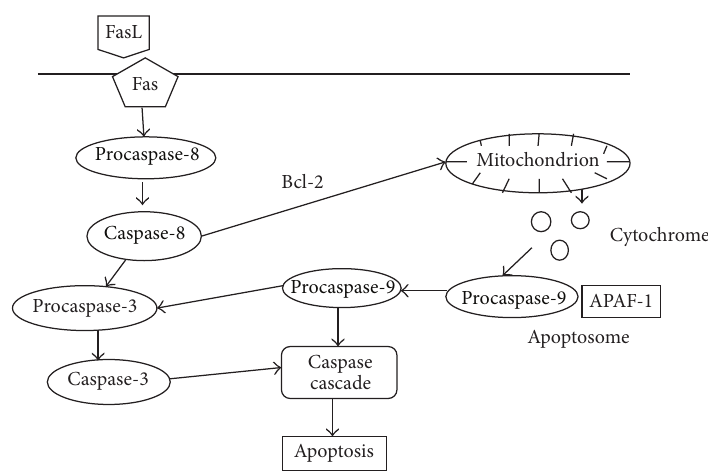
Figure 2: Schematic representation of apoptosis (extrinsic and intrinsic pathways) in